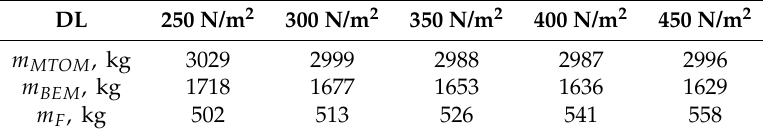
Table 8. Primary mass contributions for a variation of the disc